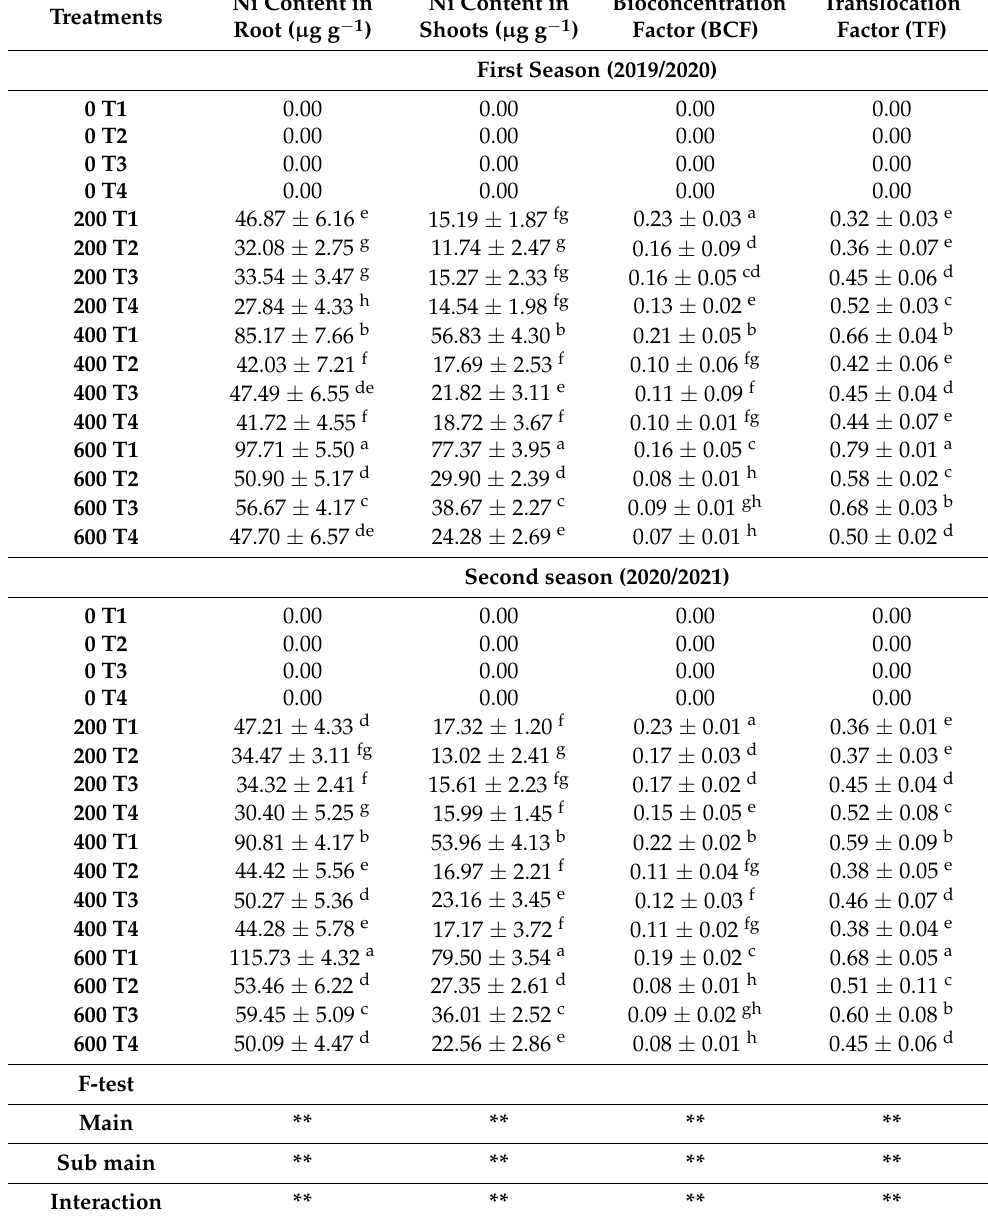
Table 4. Interaction effect of different concentrations of Ni and bacterial inoculation on the content of Ni in the roots and shoots, bioconcentration, and translocation factors in faba bean plants at 60 days after sowing during the 2019/2020 and 2020/2021 seasons.